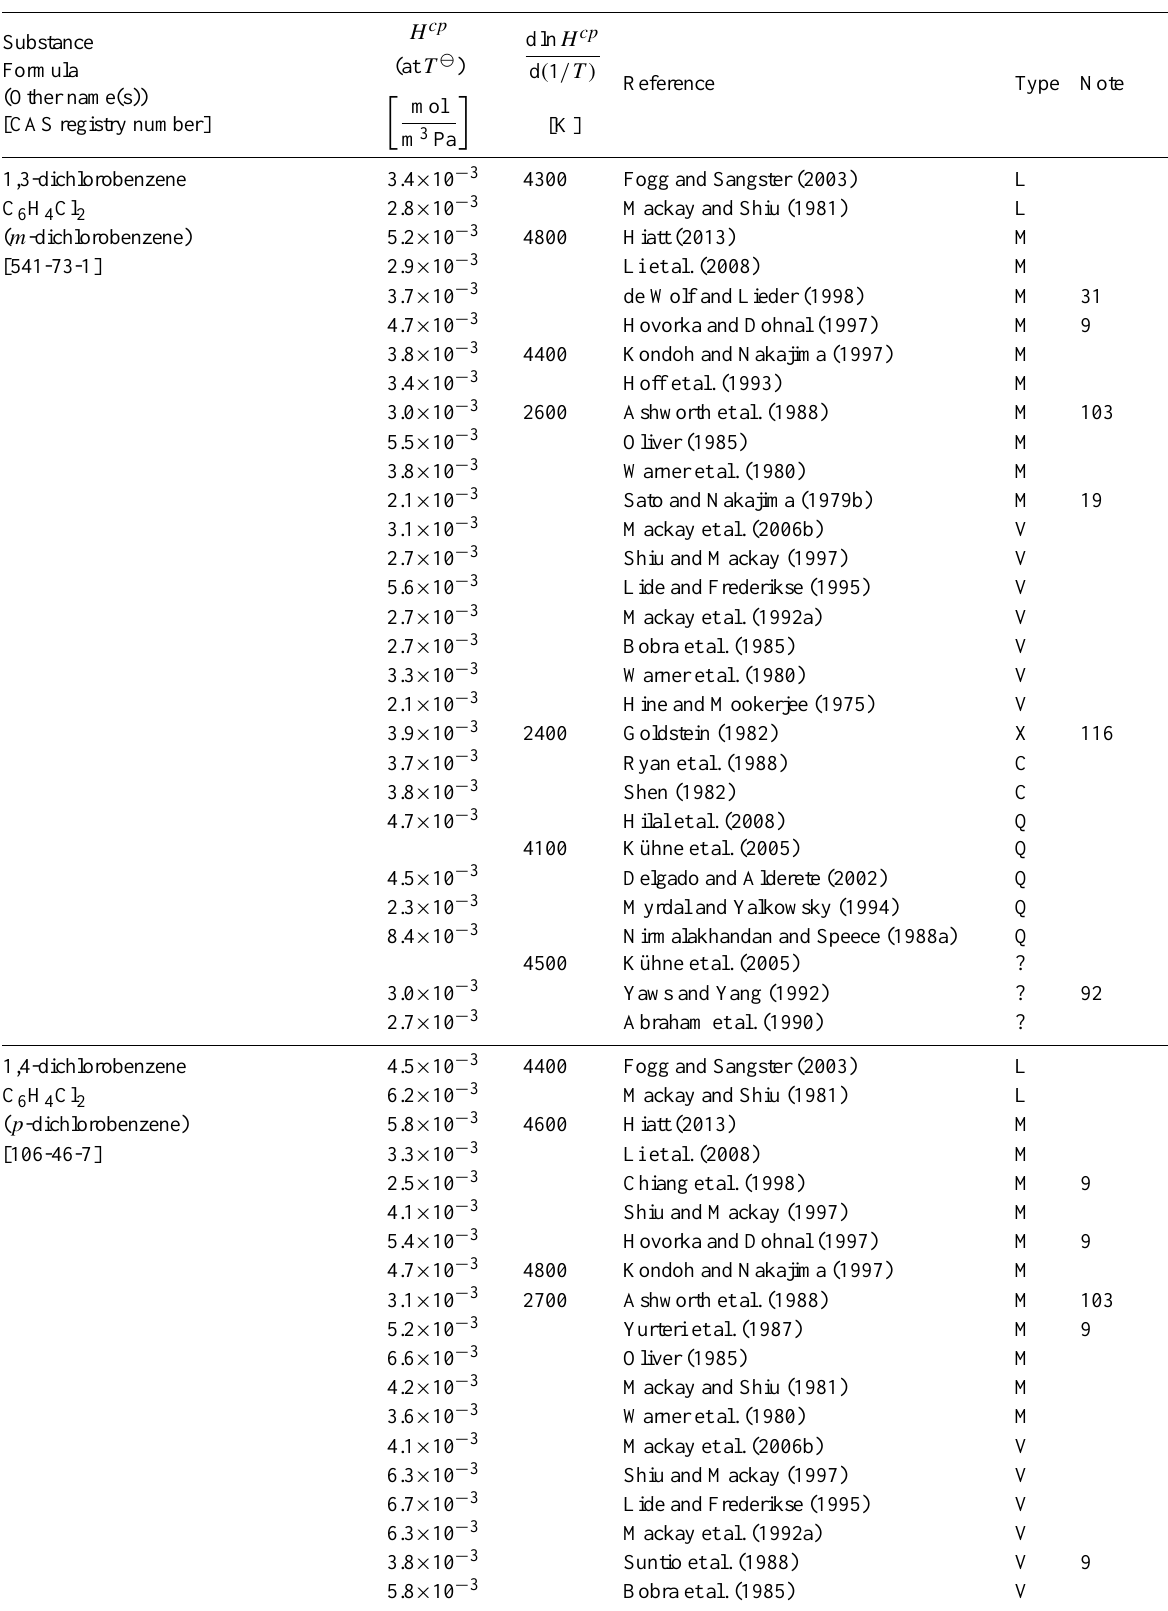
Table 6: Henry’s law constants for water as solvent